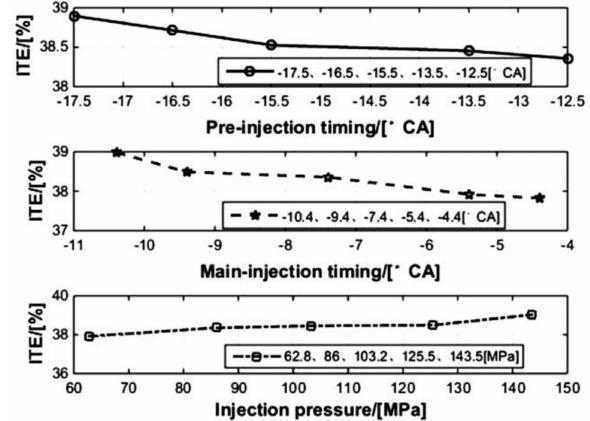
Figure 8. Effects of different injection parameters on